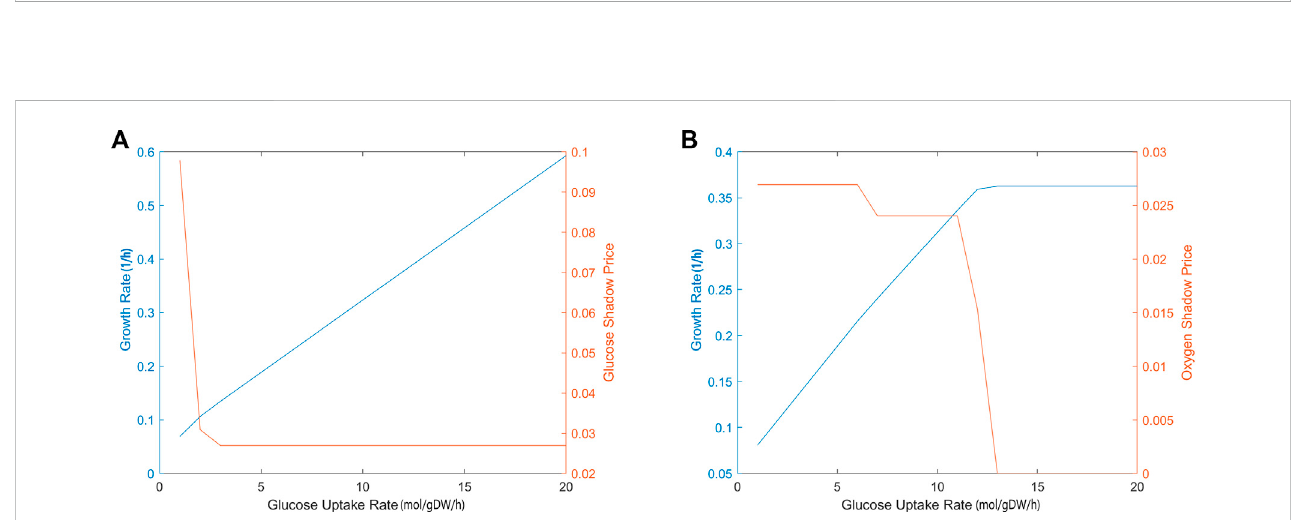
FIGURE 3 The calculated shadow prices of each solution based on glucose (A) and oxygen (B) uptake rates. The x-axis gives the fl ux of glucose uptake (EX glc D e) and oxygen uptake (EX o2 e). The y-axis on the left side shows the biomass objective function calculated depending on the change in glucose uptake. The y-axisontherightsidegivestheshadowpricesofglucoseandoxygen,respectively.Duringglucoseuptake,theamountofoxygenwas fi xedat4 mmol/gDW/ h and during oxygen uptake, the amount of glucose was fi xed at 4 mmol/gDW/h,